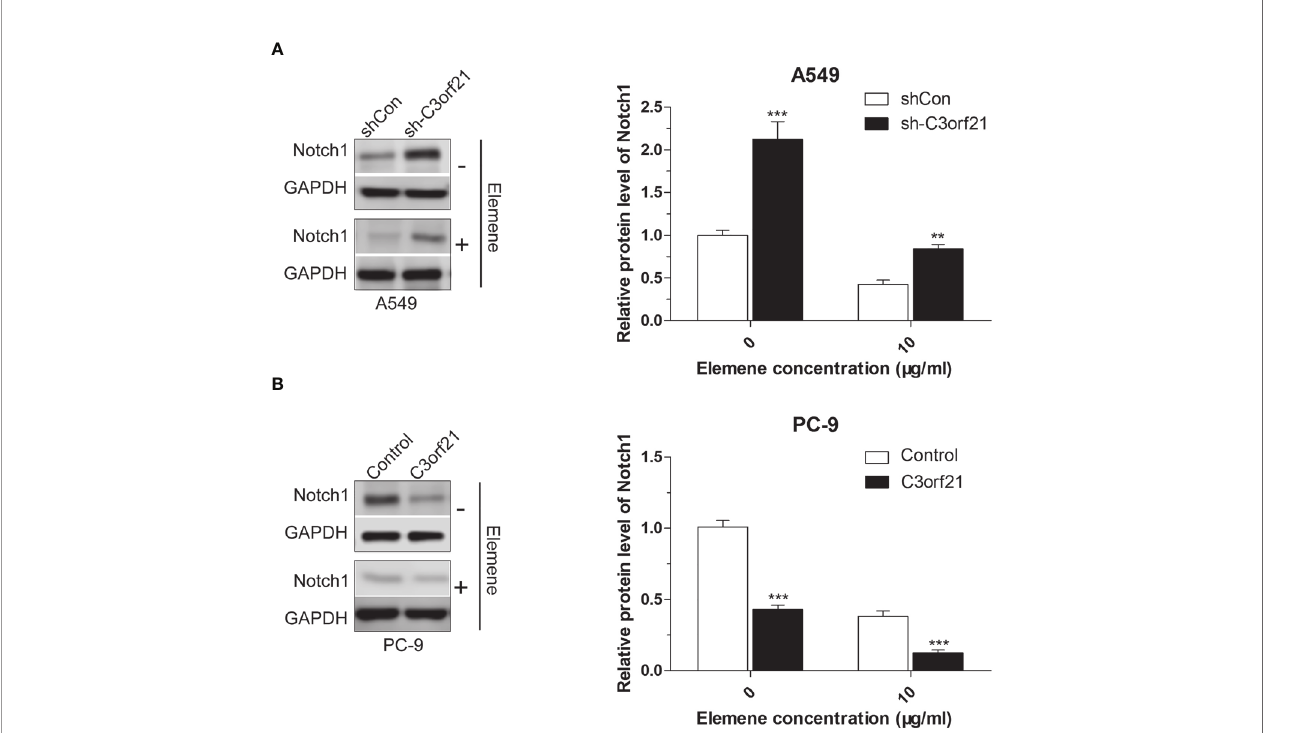
FIGURE 8 | Beta-elemene decreases C3orf21 protein expression in NSCLC cells. The indicated NSCLC cells were treated with, or without, beta-elemene for 24 and their relative levels of Notch1 protein expression (A, B) were quanti fi ed by Western blot. Data are representative images or present as mean ± SD of each group from at least three biological experiments. **P < 0.01 and ***P < 0.001 vs. the